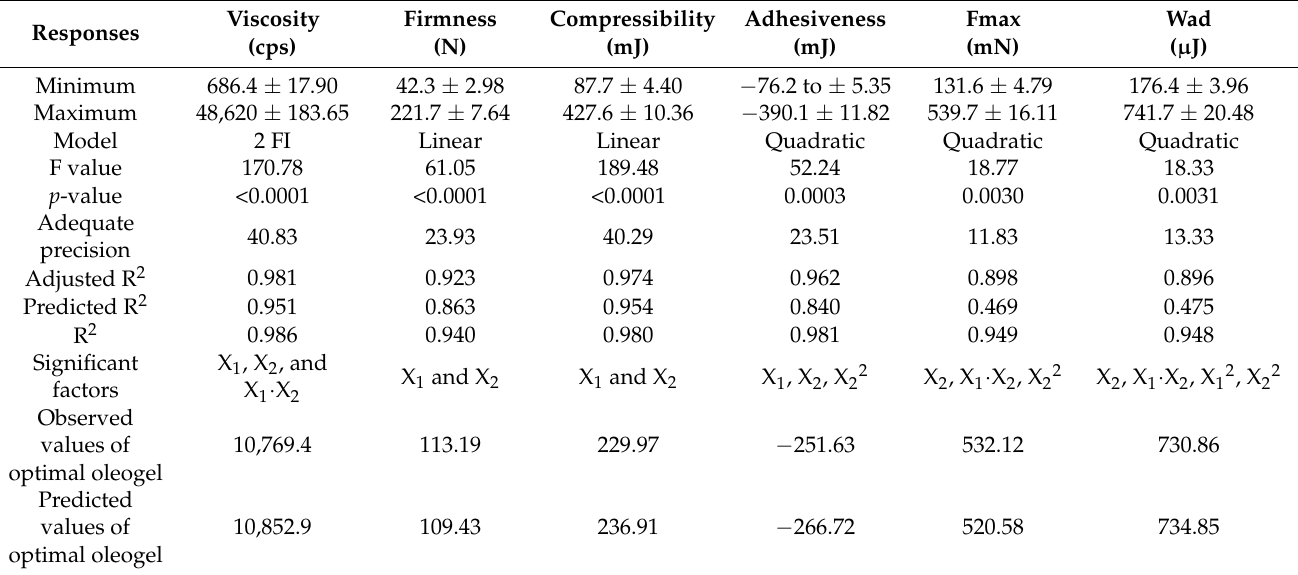
Table 2. Output data of the central composite response surface statistical design with the predicted and observed values of the optimized oleogel